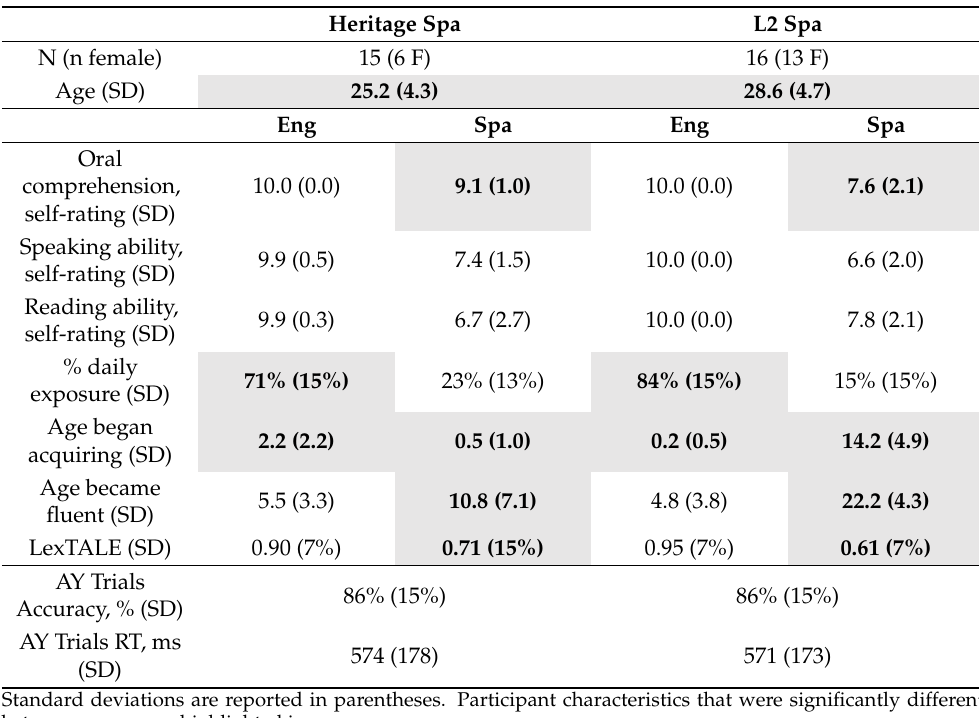
Table 1. Summary of participant